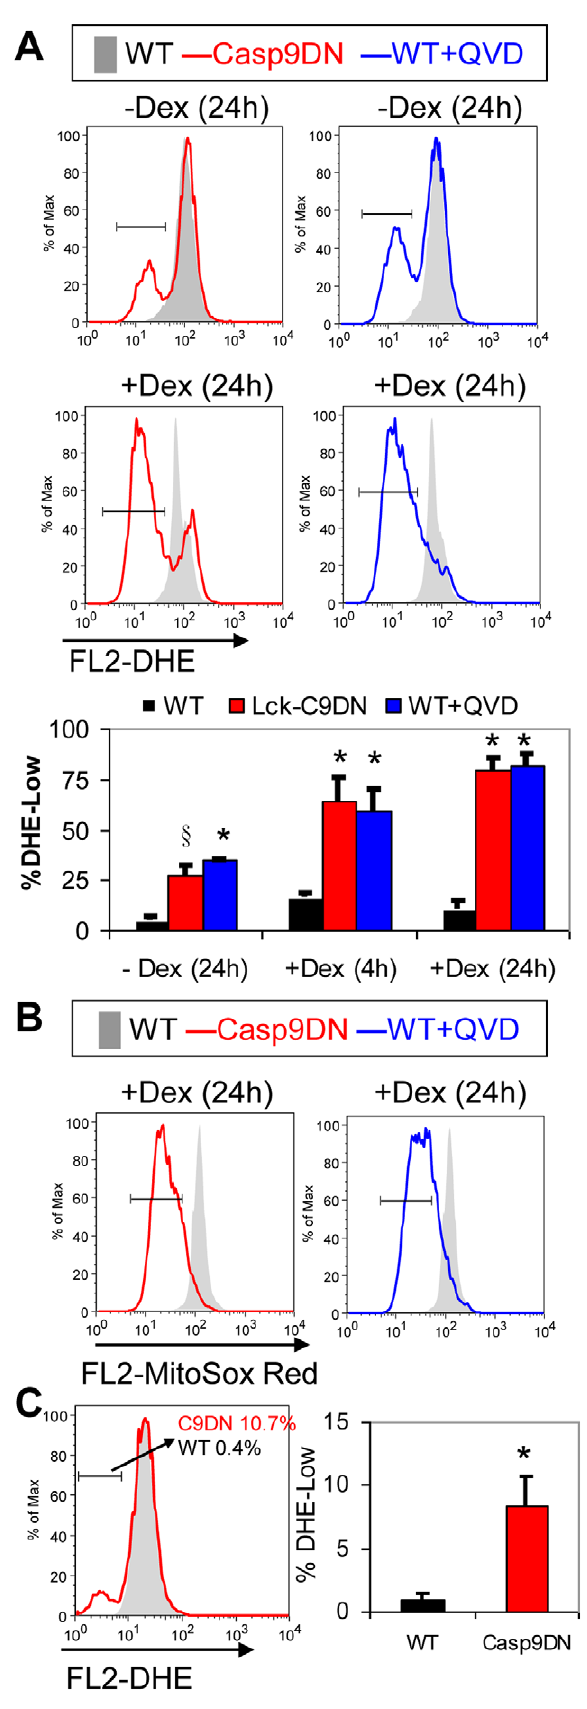
Figure 3. Casp9DN reduces ROS levels in primary thymocytes. A ) Representative histogram overlays of DHE stained viable thymocytes is shown. All cells were treated with or without Dex as indicated. Caspase activity was inhibited by either Casp9DN expression (red line, Casp9DN) or Q-VD-OPh treatment (blue line, WT + QVD) and compared to control cells (gray shaded, WT-wild type thymocytes). For